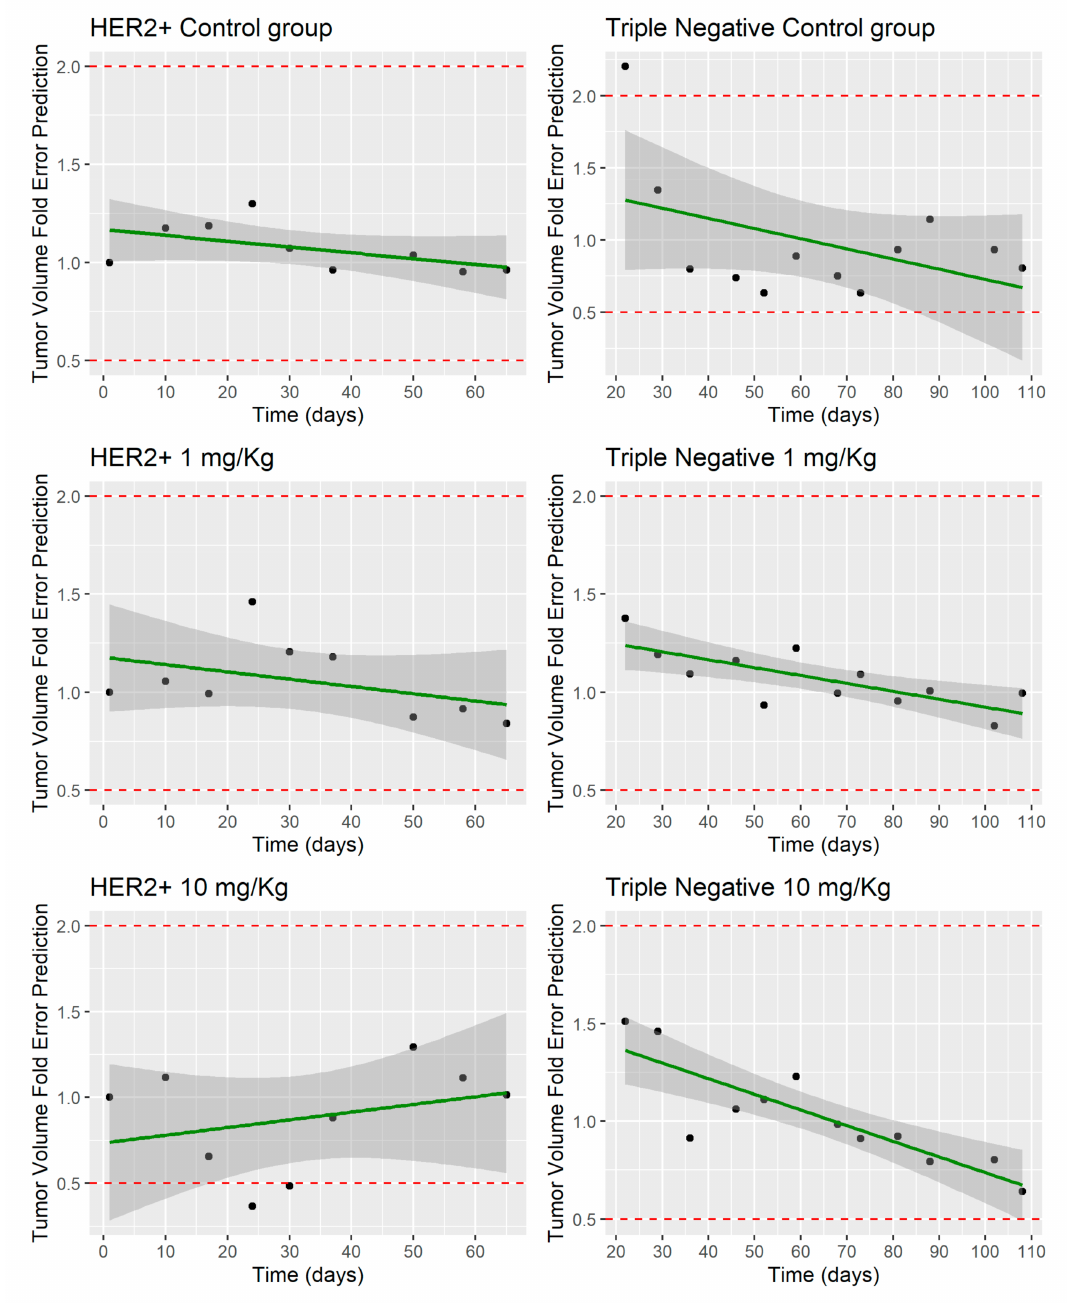
Figure 5. Evaluation of tumor volume predictions in unperturbed and perturbed (1 and 10 mg / kg) groups in HER2 + and Triple Negative cell lines. Red dashed lines represent the validation range (0.5 and 2-fold error). Green solid line represents the linear regression of the data. Black dots represent the fold-error with the mean profile for each